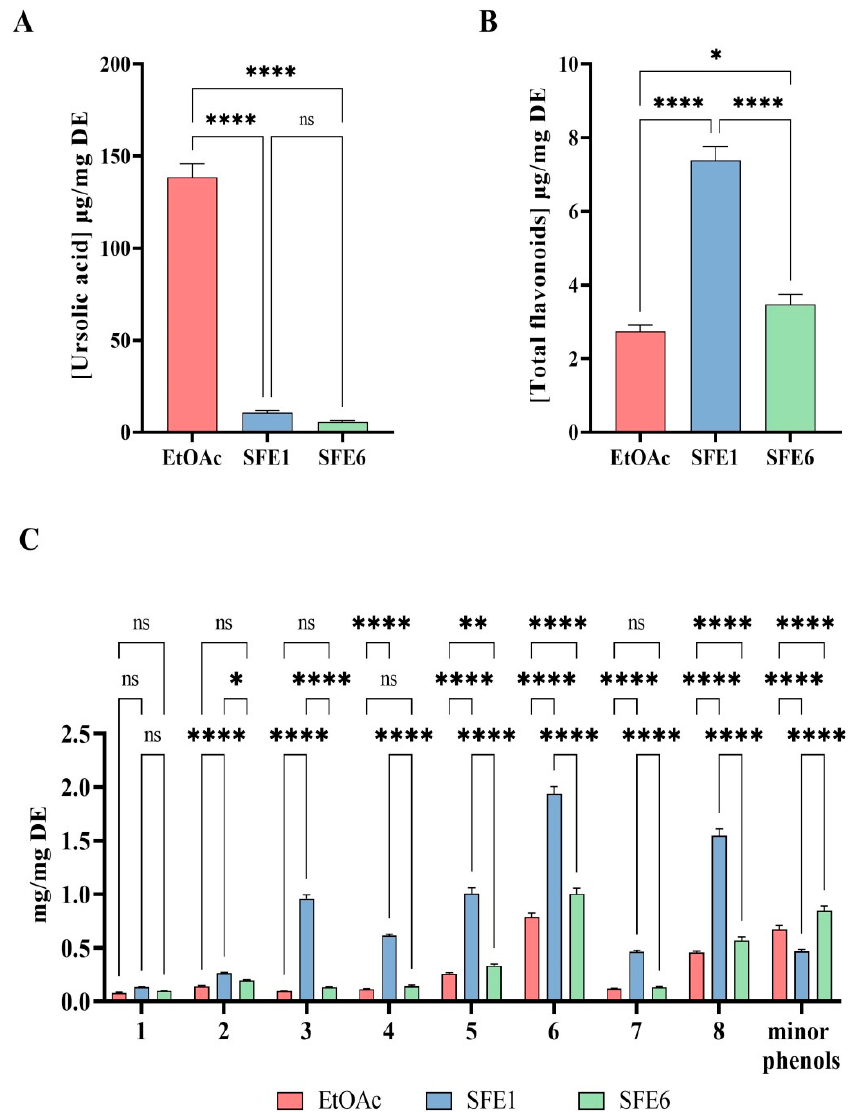
Figure 3. Total amount of ursolic acid ( A ), sum of flavonols and minor phenols ( B ) and distribution of each flavonols ( C ) evaluated on dried extract (DE). The data are a mean of three independent determinations. Data sets were analyzed by one ‐ way ANOVA and two ‐ way ANOVA followed by Tukey’s post ‐ hoc test. Ns: not significant; C: control sample; (*) p < 0.05, (**) p < 0.01 and (****) p <